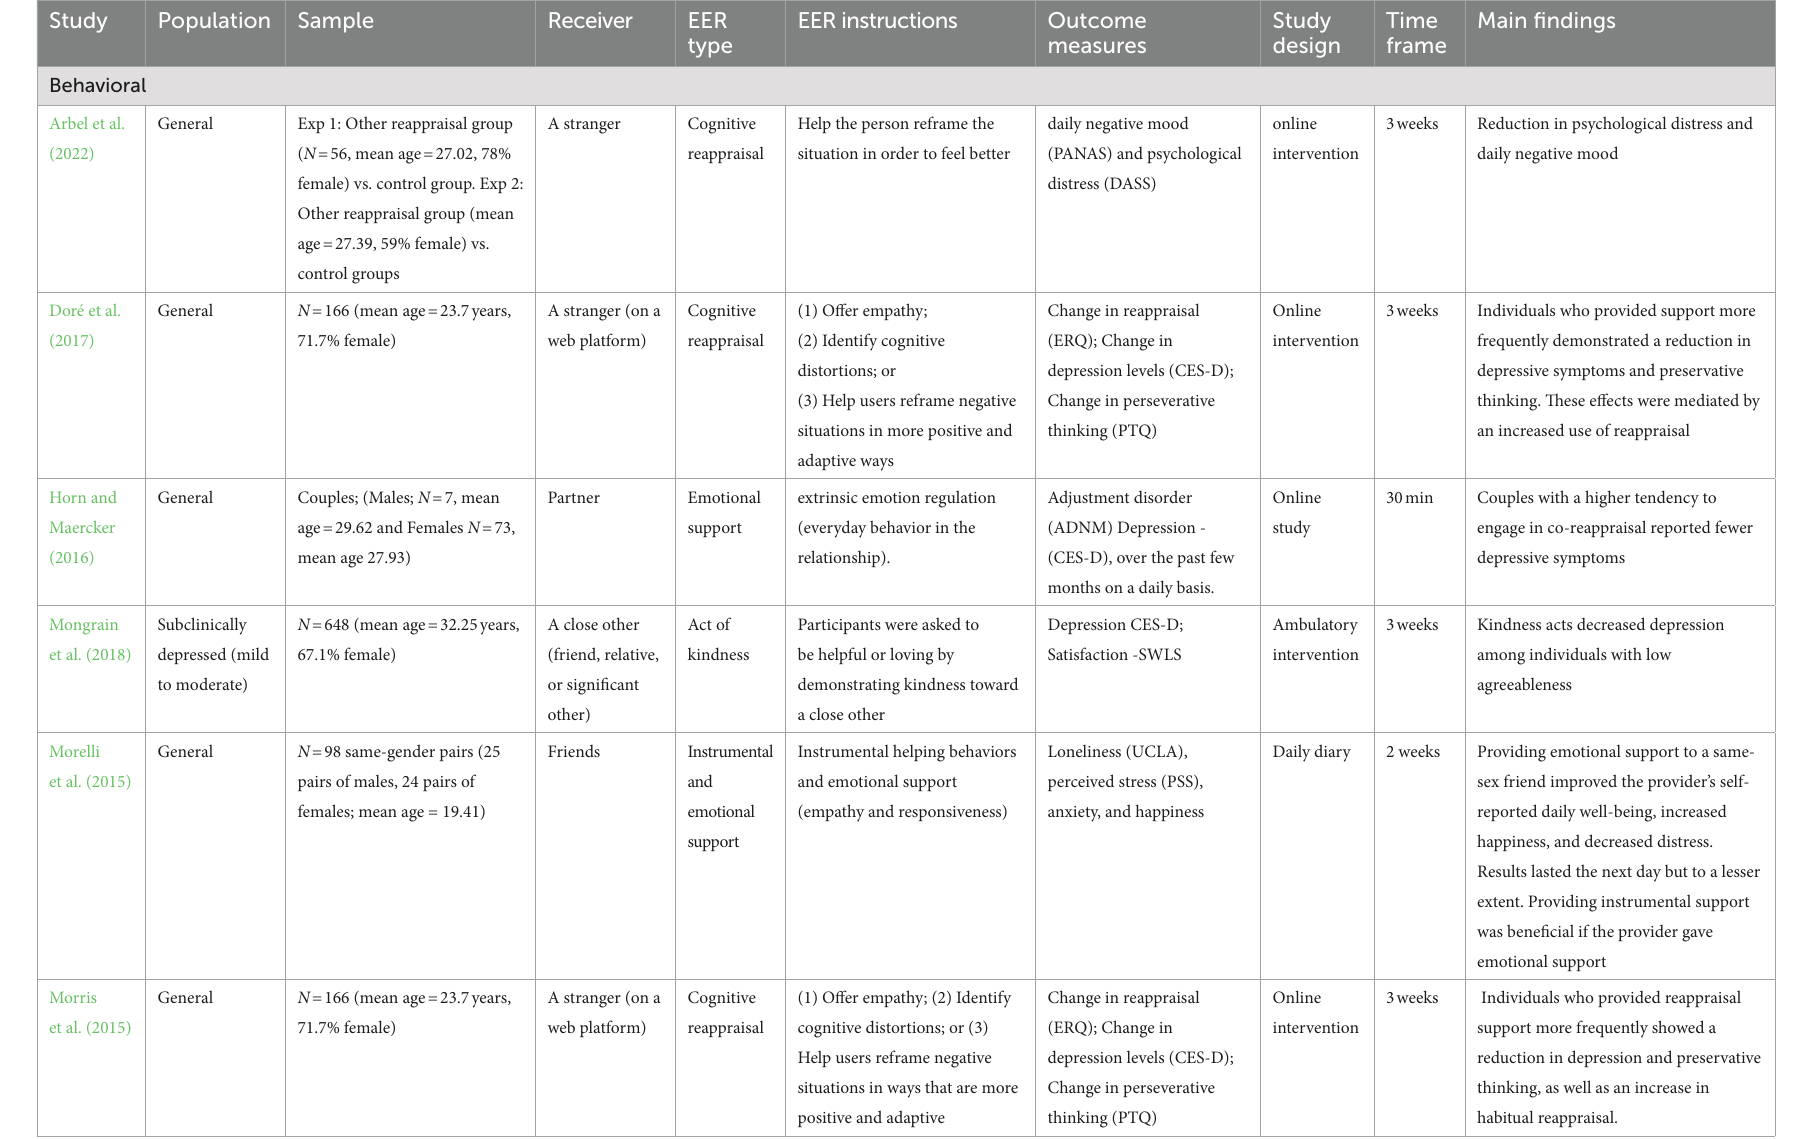
TABLE 1 Summary of the existing empirical research on the benefits of EER to the provider.